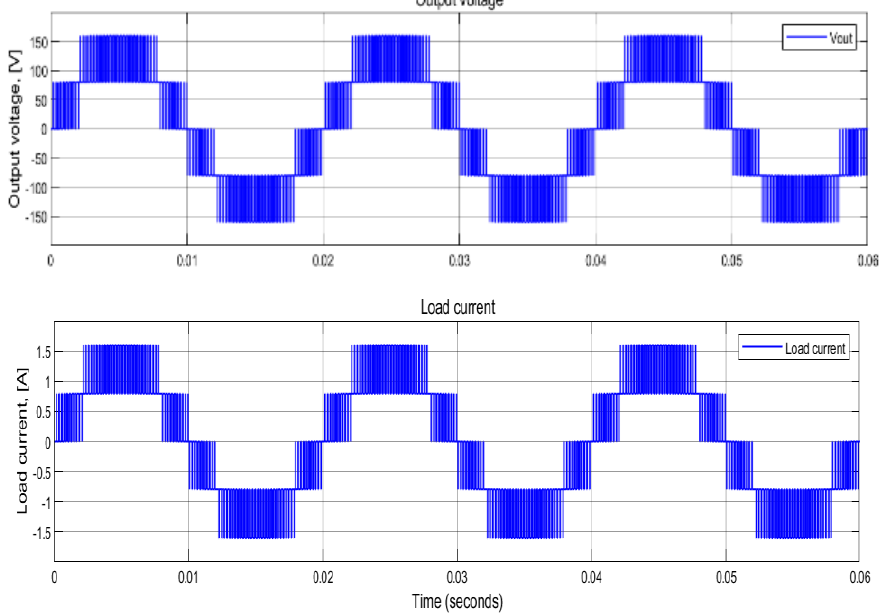
Figure 18. Output voltage and output current waveforms.